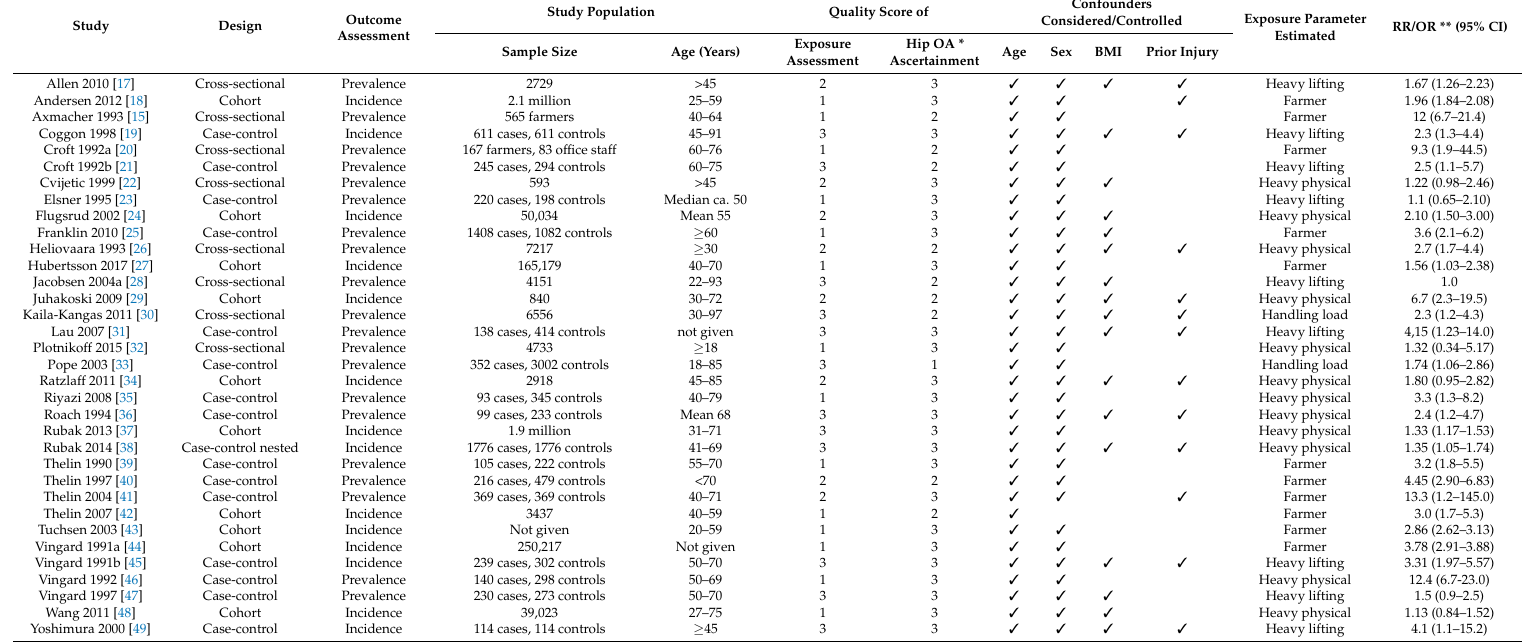
Table 3. Epidemiological evidence of heavy occupational workload and the risk of hip